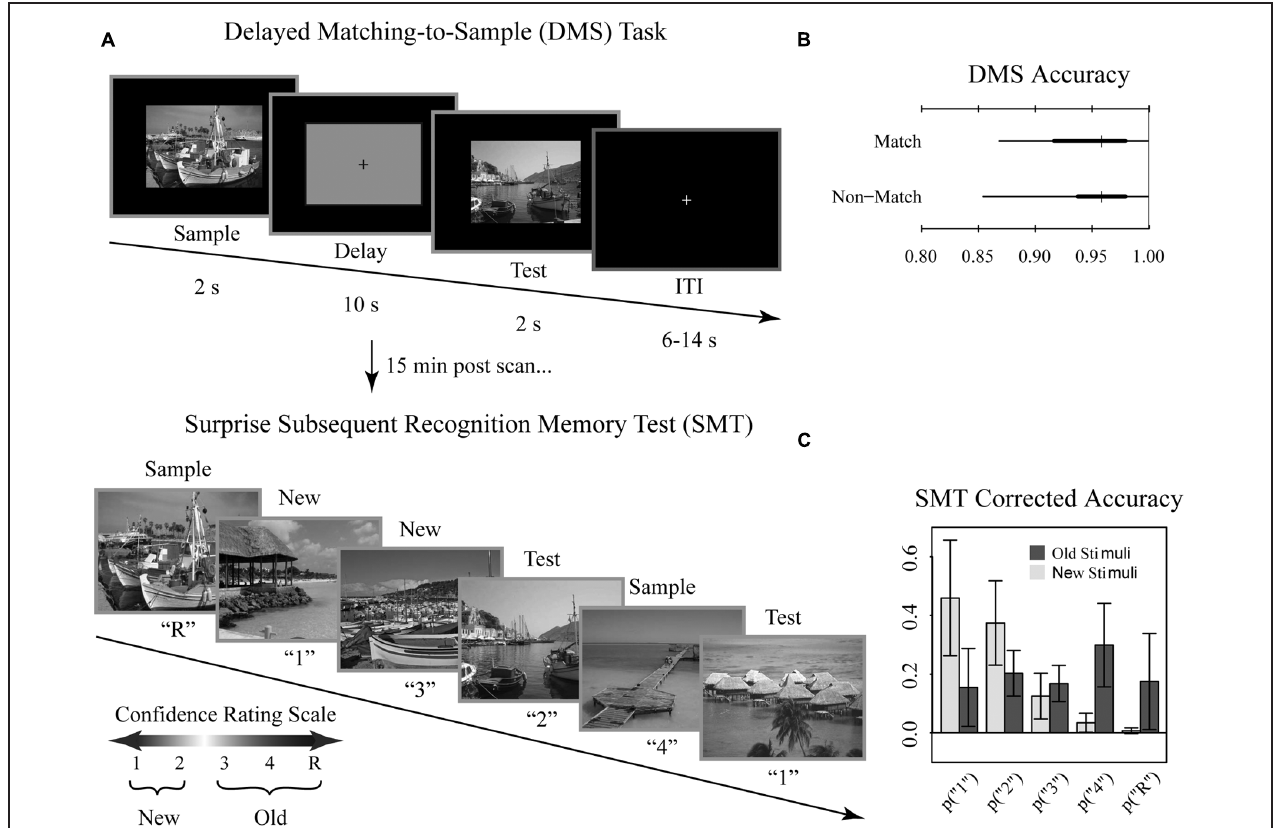
FIGURE 1 | Tasks and behavioral results. Recognition memory task adapted from Schon et al. (2004). (A) Participants were first shown a series of 144 randomized, trial unique but content similar outdoor scenes in the context of a delayed match to sample (DMS) working memory (WM) task during fMRI scanning. Approximately 15 min after completion of the fMRI scanning session, participants were administered a surprise subsequent memory test (SMT) where